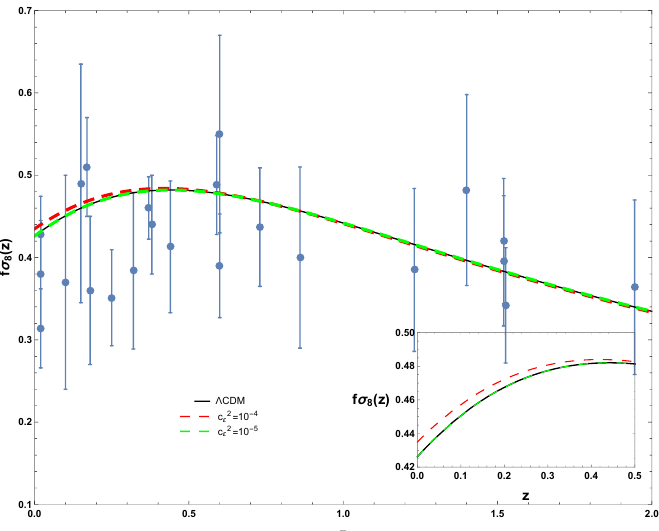
Figure 3. Dependence of f σ 8 ( z ) on z for a non-vanishing sound-speed parameter ( m = α = β = µ = ν =